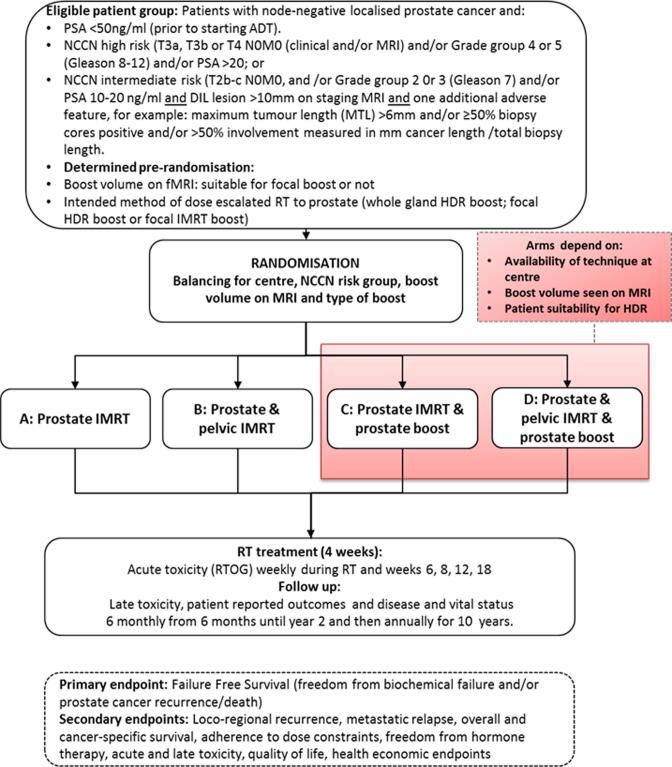
PIVOTALboost Trial Schema.